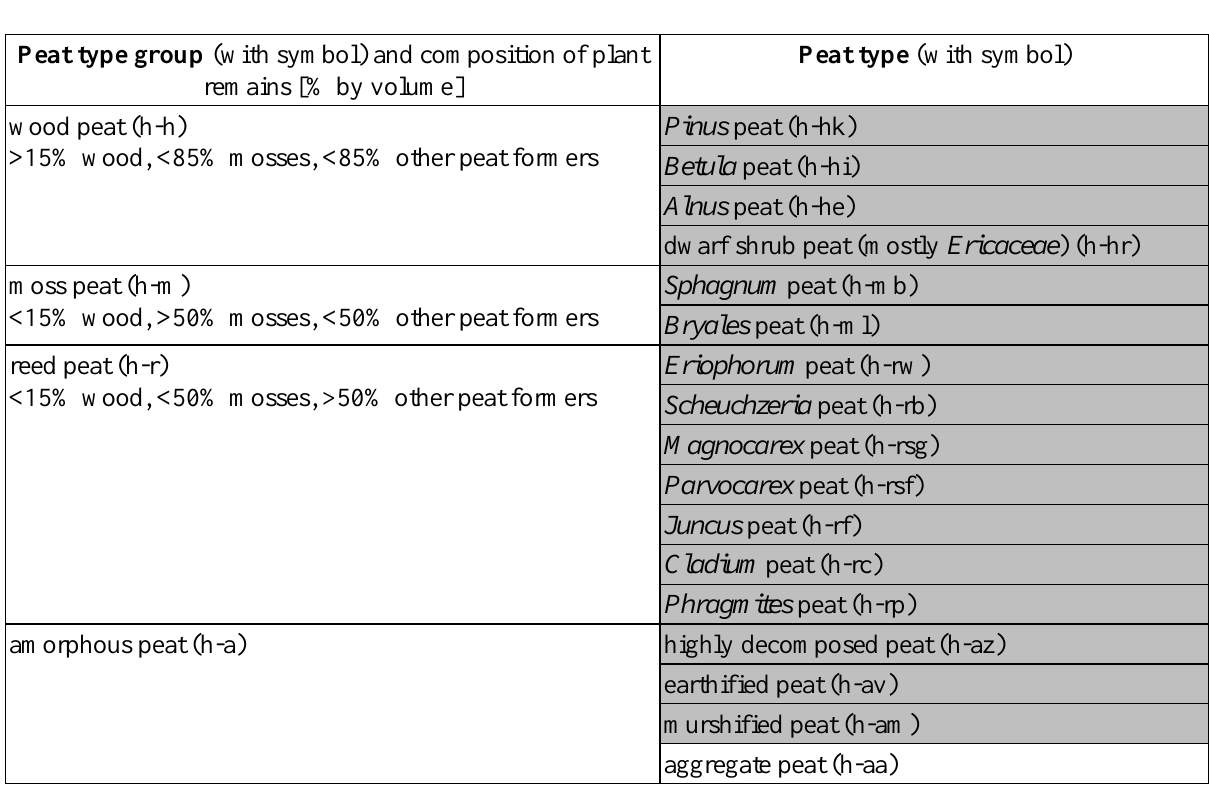
Table A1.4. Peat classification of the soil mapping manual of the former German Democratic Republic TGL 24300/04 (1985), slightly modified and translated from German, compared to the peat types included in our key and portraits (grey).